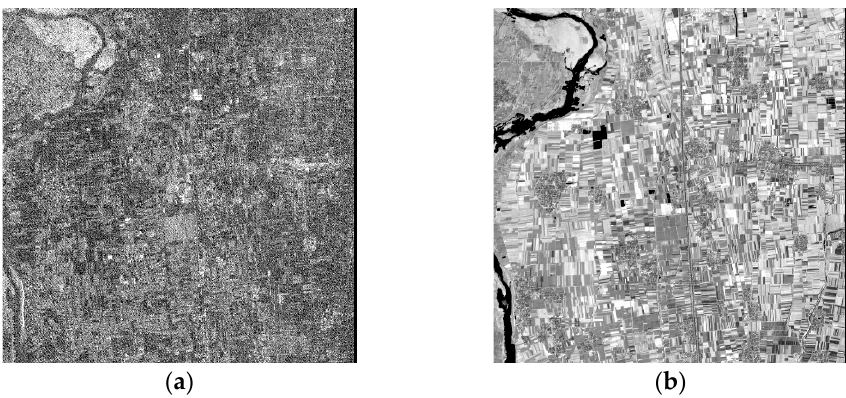
Figure 4. Comparison of band information with maximum image entropy and minimum image entropy. ( a ) band = 1, image entropy = 5.37; ( b ) band = 50, image entropy = 9.24.